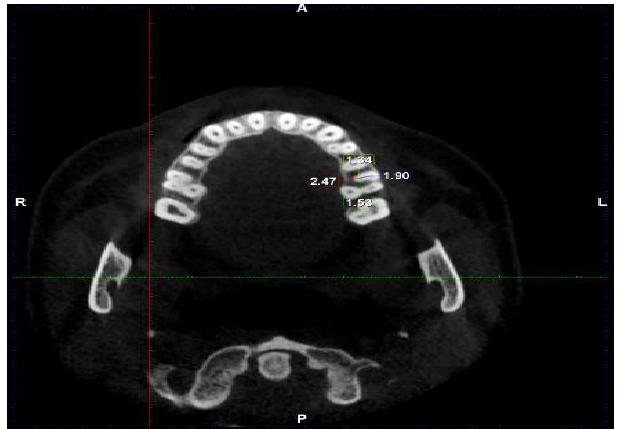
Fig. 2- A sample measurement on the CBCT image in the middle one- third.